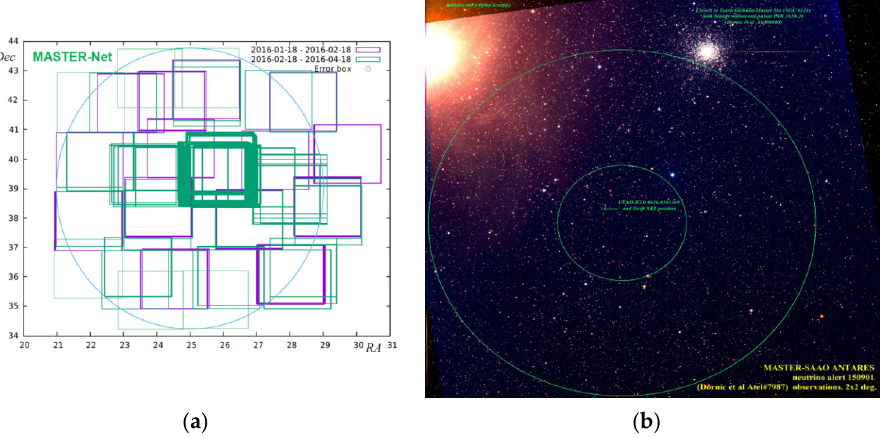
Figure 15. ( a ) MASTER cover map of IceCube IC160217 triplet error-box, observed by -Kislovodsk, -Tunka, -IAC telescopes during 1 month before trigger (magenta squares 18 January/February 2016) and 2 months after (green); ( b ) MASTER image of ANTARES alert ANT 150901.32 [36] M5 globular cluster, Swift transient (the source was stable in optic in BVRI), and Antares star (1.3 deg. from the 3- σ error-box center) are marked.